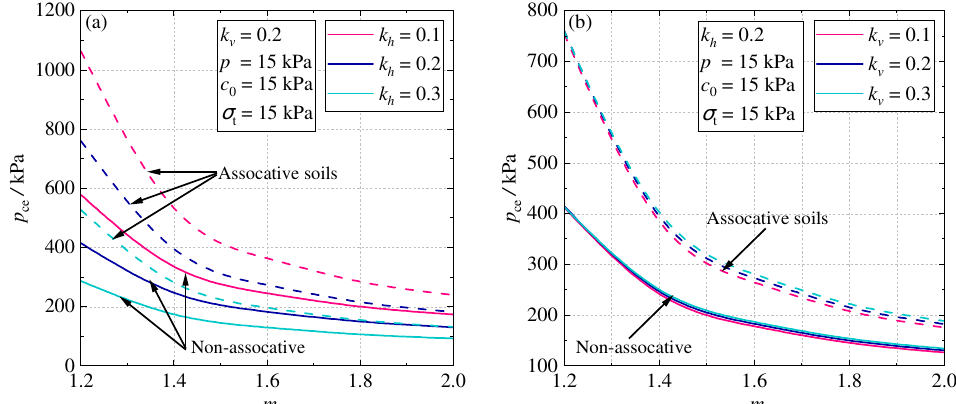
Figure 4. Seismic bearing capacity versus nonlinear coefficient and seismic coefficients: ( a ) horizontal seismic coefficient; ( b ) vertical seismic coefficient.